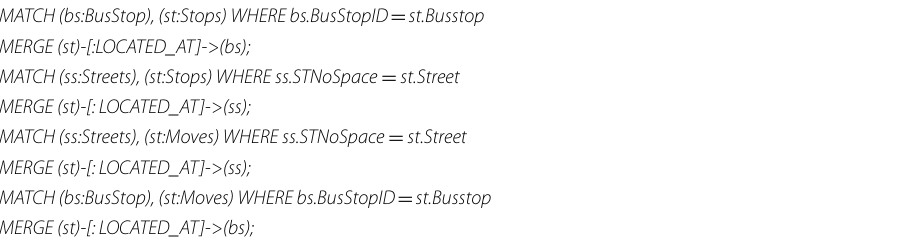
Table 4 Cypher query used to create the edges between mobility and platial subgraphs MATCH (bs:BusStop), (st:Stops) WHERE bs.BusStopID